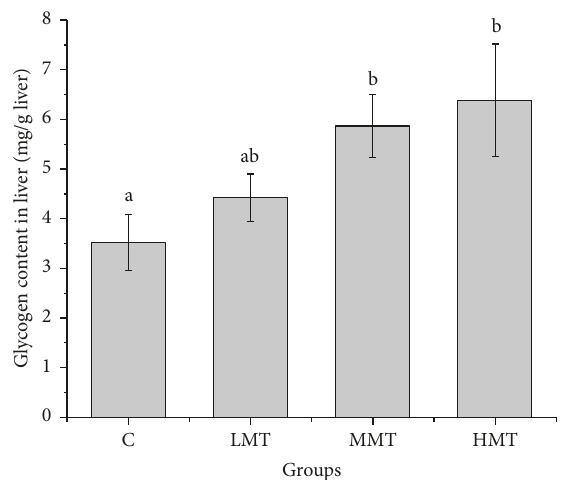
Figure 4: Effect of Xinjiang maca on glycogen content in liver (C, control; LMT, low-dose maca-treated group; MMT, medium-dose maca-treated group; HMT, high-dose maca-treated group. Each value represents the mean ± SD ( 𝑛 = 10 ). Different letters indicate significant differences among groups ( 𝑃 < 0.05